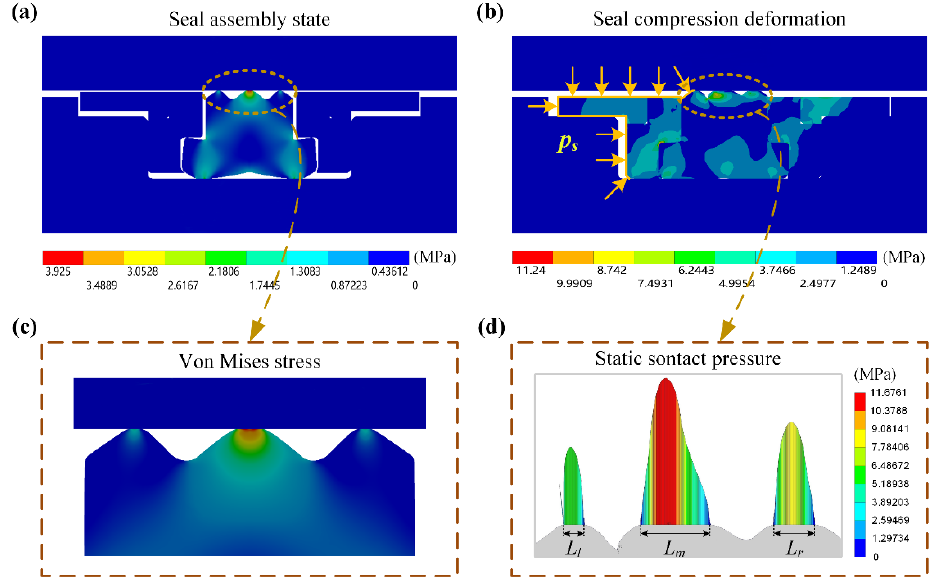
Figure 4. Finite element analysis of sealing system installation and pressurization: ( a ) simulation of installation; ( b ) simulation of pressurization; ( c ) enlarged view of seal lip stress; ( d ) static contact pressure distribution.